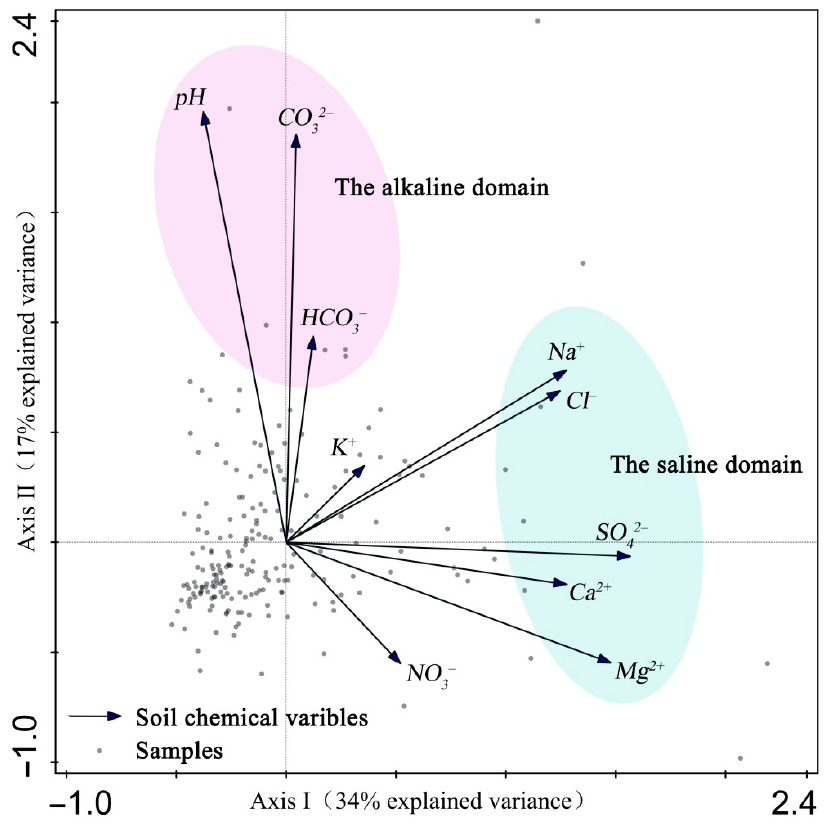
Figure 2. Ordination diagrams from the correlation-based indirect gradient analysis (PCA). Variability explained by the first two axes (correlation biplot) of the distribution of 10 chemical variables in 204 soil samples is represented.